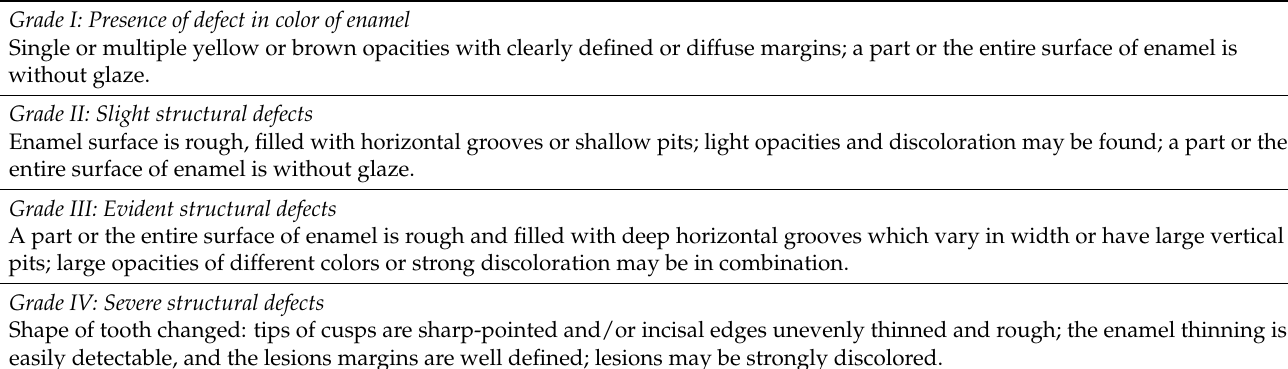
Figure 2. ( a ) Hypoplasia and opacity of the enamel with clearly defined margins on the maxillary central incisors in a 25-year-old female CeD patient; ( b ) Slight structural enamel defects of the occlusal surface, with an evident structural defect on the mesio-buccal cusp of the first maxillary right molar in a 17-year-old female CeD patient. Table 2. Grading of the CeD-related DEDs adapted from Aine (1986) [23].